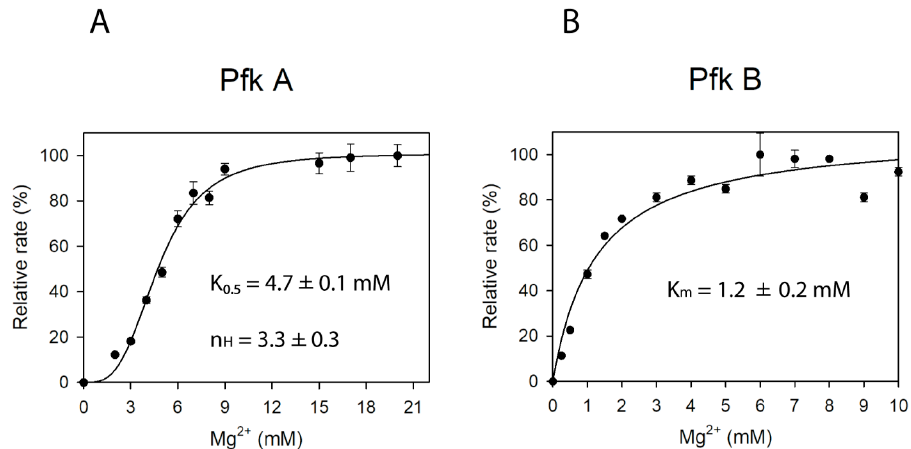
Figure 3. The dependence of Pfk A and Pfk B activities on concentration of Mg 2+ . Individual reactions were performed in buffers containing 1 mM F6P and 1 mM ATP with the concentration of Mg 2+ varied. The data were fitted to Equation (2) ( A ) and Equation (1) ( B ). The velocities were normalized (100% determines the maximum achievable velocity).